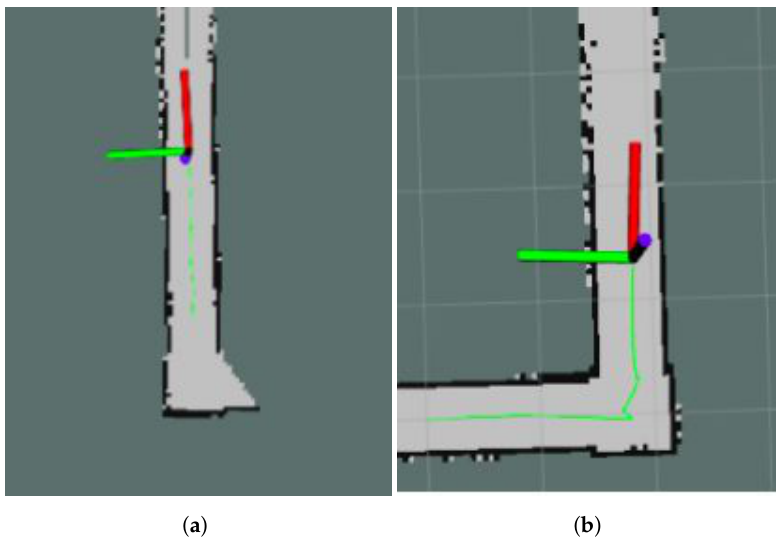
Figure 17. Robot ‘Raptor’ path tracking. ( a ) Pathplanning—right turn; ( b )